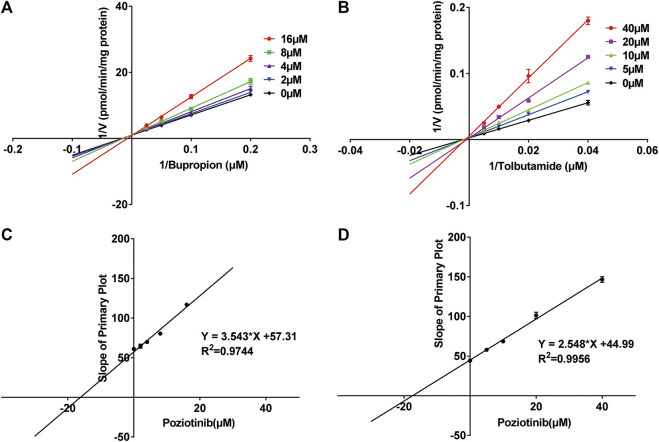
Primary Lineweaver–Burk plots of poziotinib (0, 2, 4, 8, 16 μM for bupropion, and 0, 5, 10, 20, 40 μM for tolbutamide) inhibited (A) bupropion (5, 10, 20 and 40 μM) and (B) tolbutamide (25, 50, 100 and 200 μM); Secondary plots for determination of Ki of (C) bupropion and (D) tolbutamide. All data were mean ± SD of triplicate determinations.